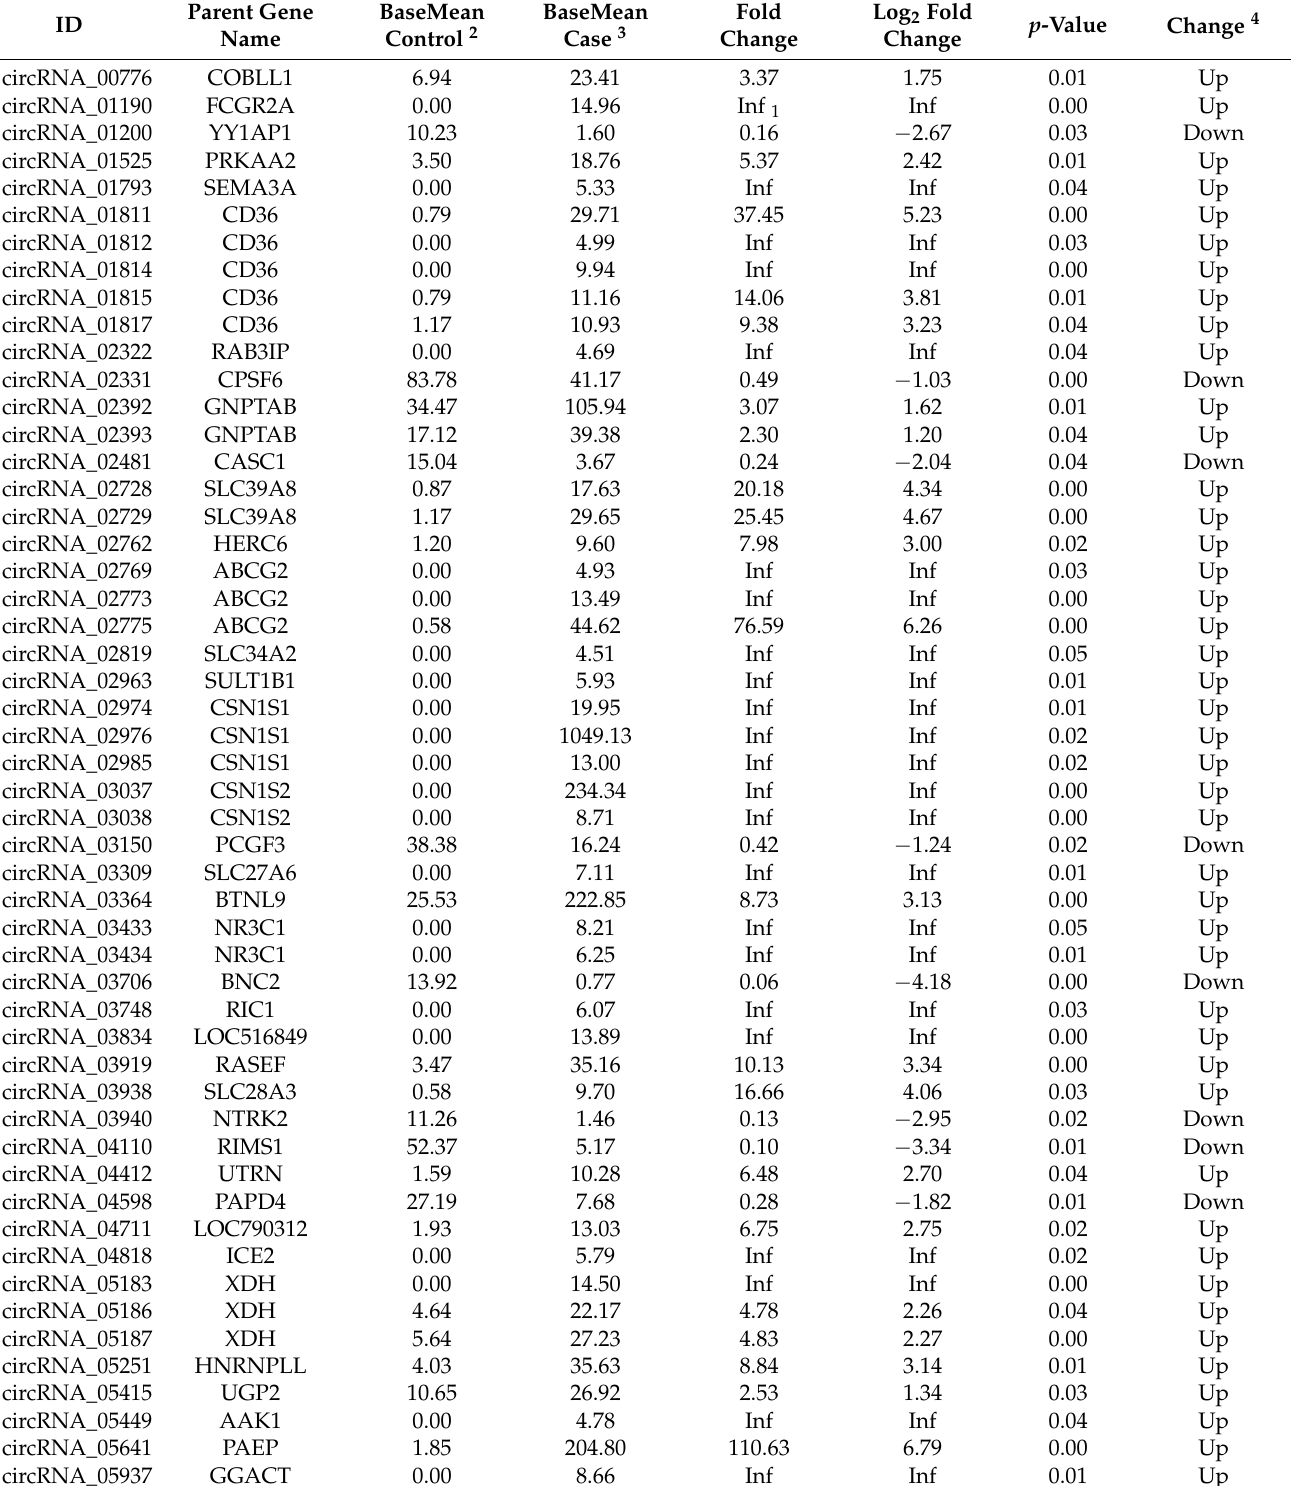
Table A1. Differentially expressed circular RNAs in mammary tissue from Holstein cows at early lactation and